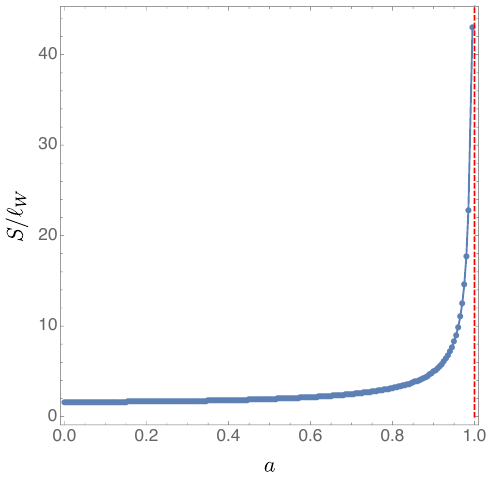
Figure 23 . The ratio j=(cid:26) as a function of Xk X , computed using a = 0 : 975 and T=k X (cid:25) 1 : 43. The dashed black line represents the (cid:13)uid calculation and the blue disks our numerical data.